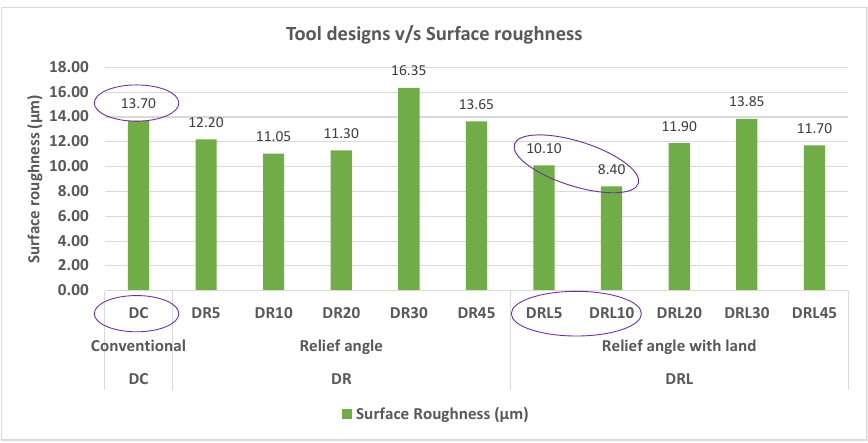
Figure 7. Effect of electrode designs on surface roughness of machined hole. Figure 7. E ff ect of electrode designs on surface roughness of machined hole.